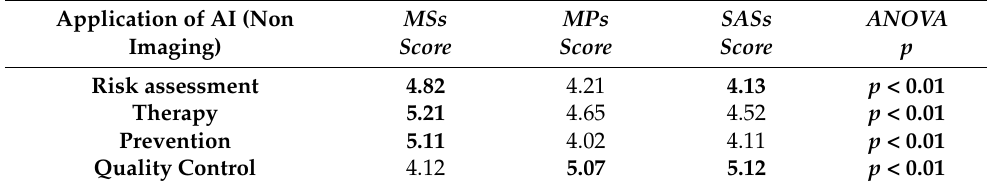
Table 4. Specific outcome of the opinion on the application of AI different from imaging.